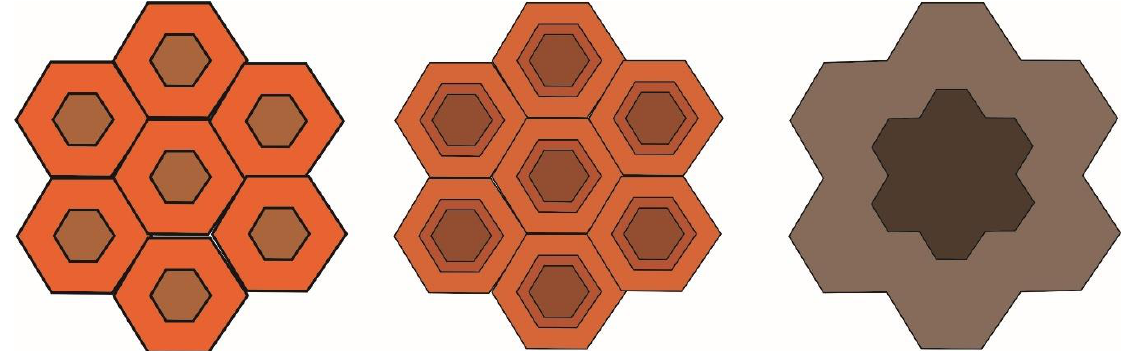
Figure 7. Schematic representation of pore formation during pyrolysis. The leftmost side of the figure shows the honeycomb-like cells of the biomass prior of the thermal degradation. As the temperature increases pores are formed (central part of the figure). Pore coalescence due to the release of volatile organic components and salt melting provokes hole enlargement and reduction of the biochar surface area.